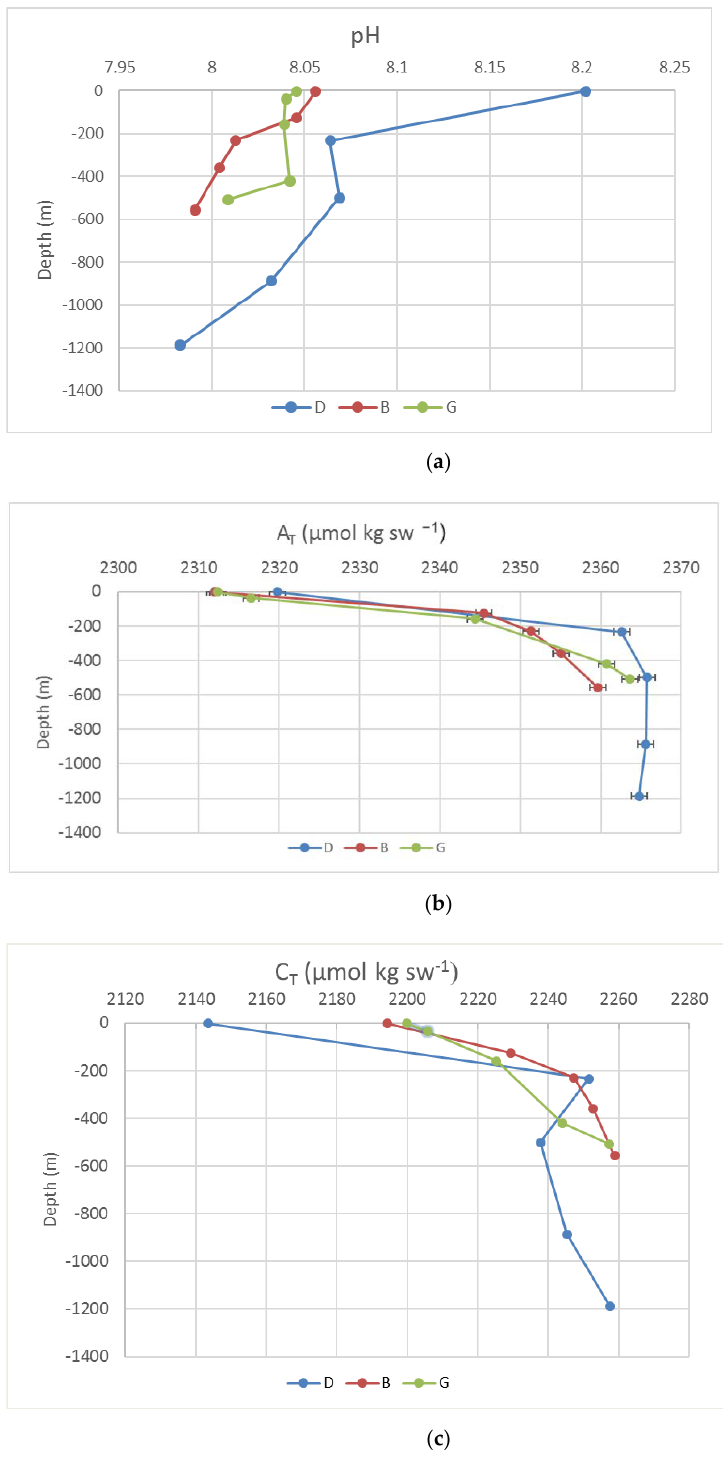
Figure 10. Vertical profile of pH, A T, and C T for the stations D, B, and G. ( a ) pH; ( b ) A T ; ( c ) C T .